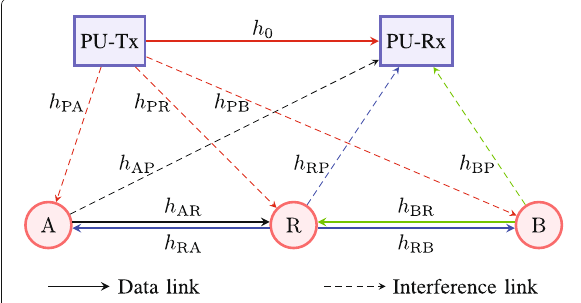
Fig. 1 Cognitive underlay two-way relaying networks with interference and imperfect channel state information